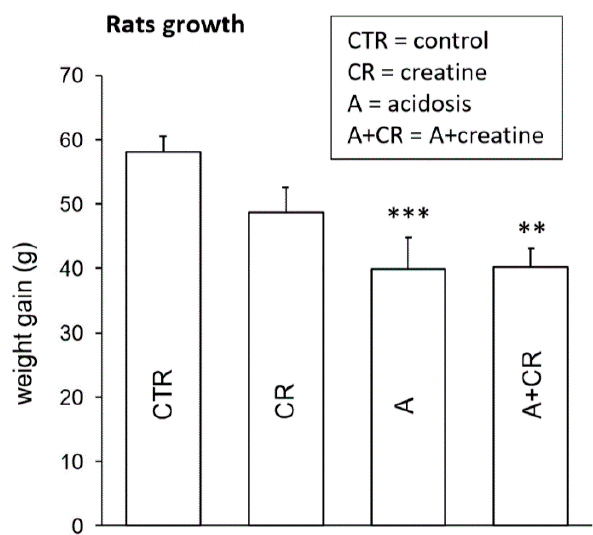
Figure 2. Rat weight (g) gain after 11 d of treatment. Values are means ± S.E. *** p ≤ 0.05 vs. control. ** p ≤ 0.05 vs. creatine. Number of experiments = 16.